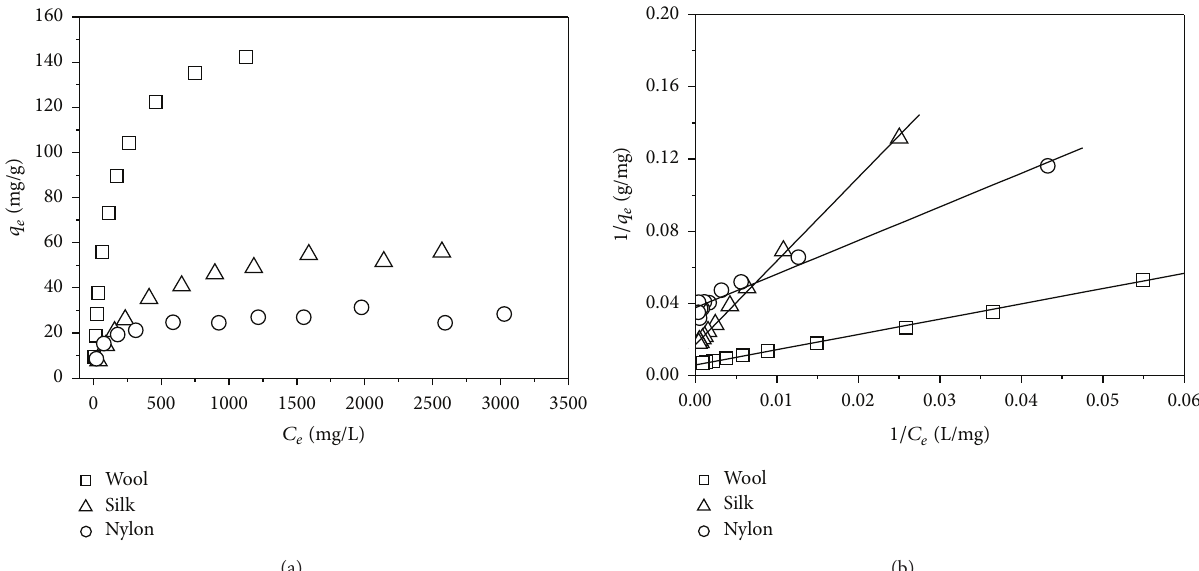
Figure 4: Plots of 𝑞 𝑒 against 𝐶 𝑒 (a) and 1/𝑞 𝑒 against 1/𝐶 𝑒 (b) of adsorption isotherms of lac dyes on wool, silk, and nylon.